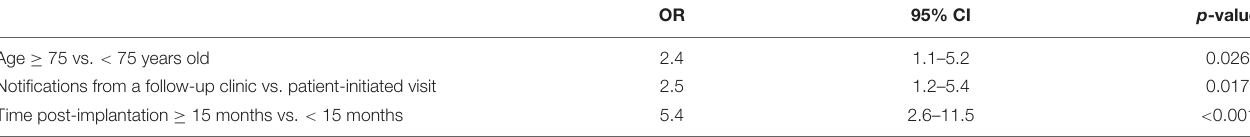
OR 95% CI p -value